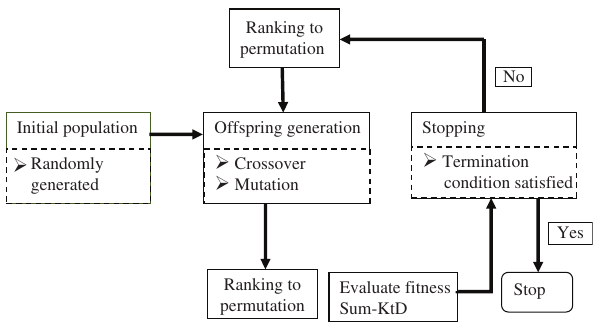
Figure 2: The Schematic Representation of Our Proposed GRS-GA-PRWOT.